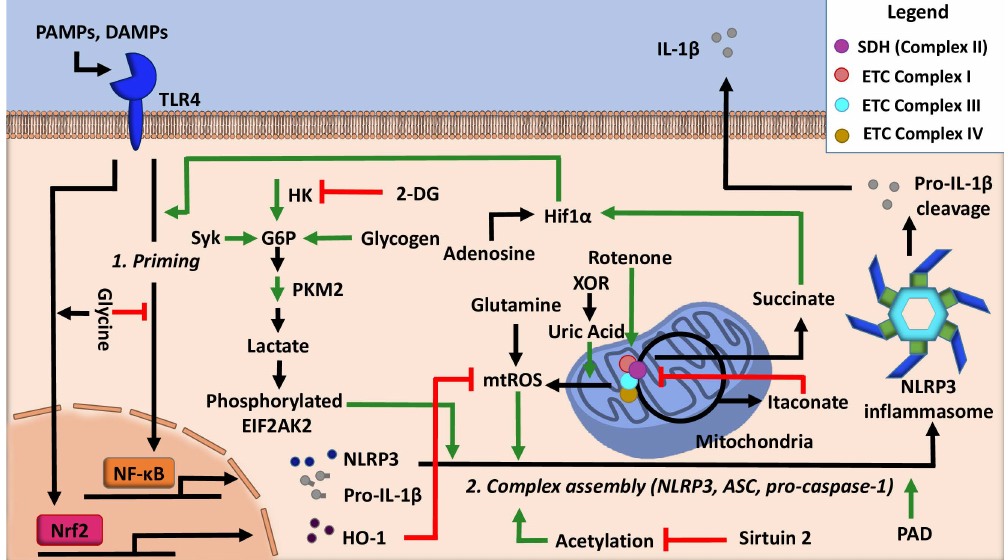
Figure 2. Regulation of NLRP3 inflammasome activity by cellular metabolic pathways. Stimulating macrophages with a priming signal increases the production of succinate, which stabilizes hypoxia-inducible factor 1-alpha (HIF-1 α ). Hif1 α , also activated by adenosine, enhances the transcription of IL-1 β . Inflammasome assembly is assisted by glycolytic flux and acetylation, which can be inhibited by 2-deoxy-D-glucose (2-DG) and Sirtuin 2, respectively. Itaconate inhibits succinate dehydrogenase (SDH) and reduces mitochondrial (mt)ROS, along with glycine, which enhances Nrf2-mediated cellular stress responses to inhibit inflammasome activation. Glutamine and xanthine oxidoreductase (XOR) via uric acid enhance mtROS. Green lines denote the promotion of NLRP3 activity, whereas red lines denote the inhibition of NLRP3 inflammasome activity. DAMPs: danger-associated molecular patterns, EIF2AK2: eukaryotic translation initiation factor 2 alpha kinase 2, G6P: glucose-6-phosphate, HK: hexokinase, PAD: protein arginine deiminase, PAMPs: pathogen-associated molecular patterns, and PKM2: pyruvate kinase M2.